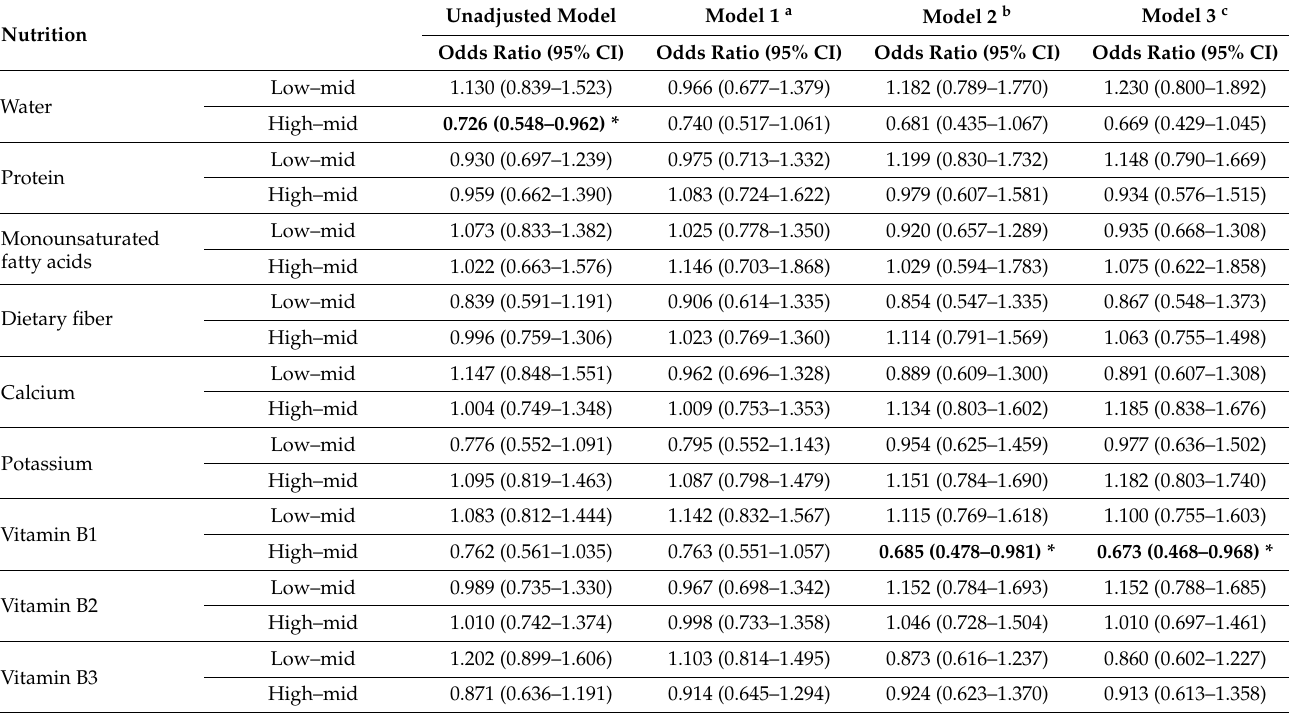
Table 2. Results of univariate multiple logistic regression analysis on association between nutrient intake and cataracts for each model, according to adjustment variables in the male group. Each nutrient intake significantly associated with cataracts in univariate simple logistic regression was used as an independent variable.